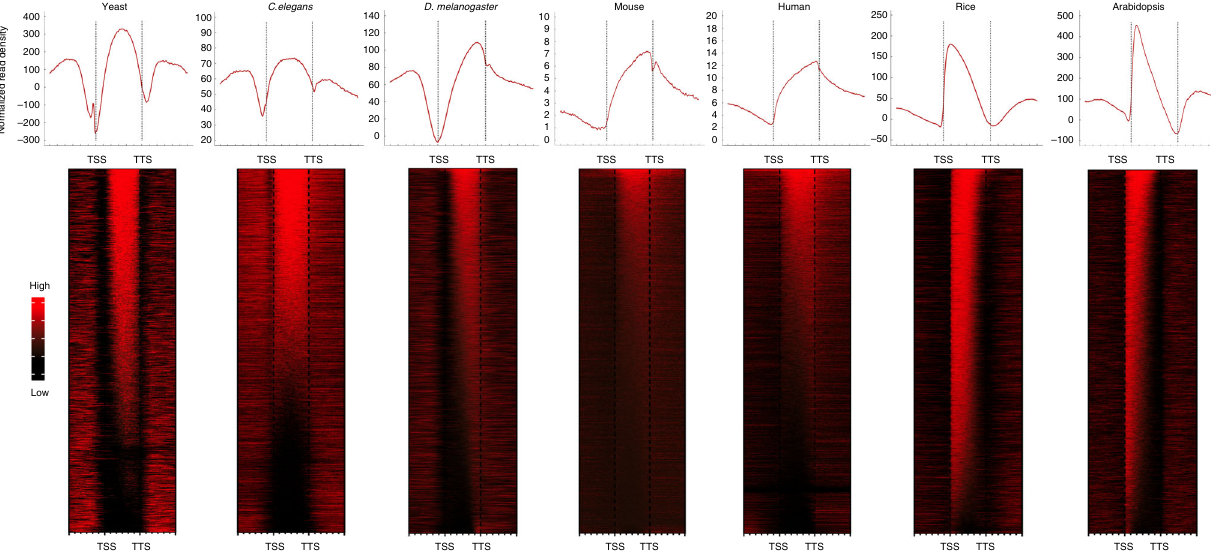
Fig. 1 Genome-wide distributions of H3K36me3 in various species. Upper panel: integrative genomic distribution of H3K36me3 in yeast, C. elegans , D. melanogaster , mice, humans, rice, and Arabidopsis . Lower panel: corresponding heatmaps of H3K36me3. Each line represents a